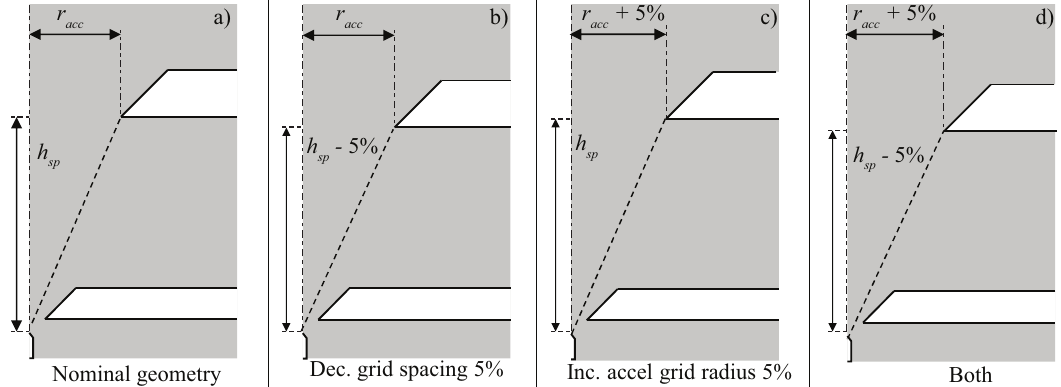
Figure 8. Varying accelerator grid geometries demonstrating methods to increase θ acc from ( a ) nominal configuration by ( b ) decreasing grid spacing, ( c ) increasing accelerator grid radius, and ( d ) a combination of spacing and radius changes. Extractor grid geometry was held constant in all configurations to ensure emission behavior was not